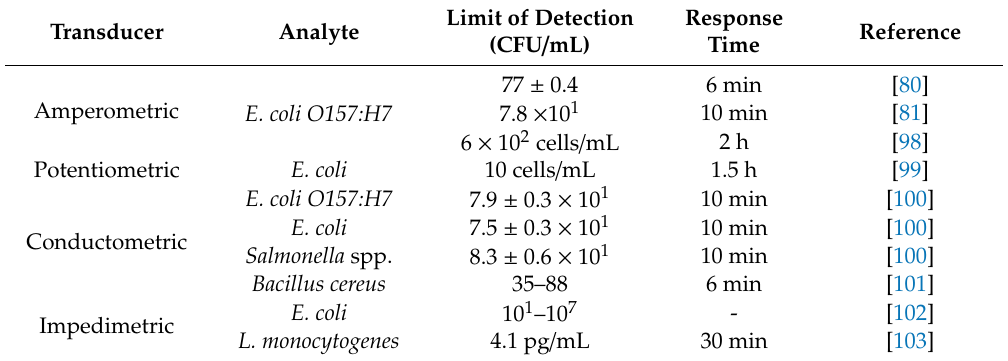
Table 2. Electrochemical foodborne pathogen